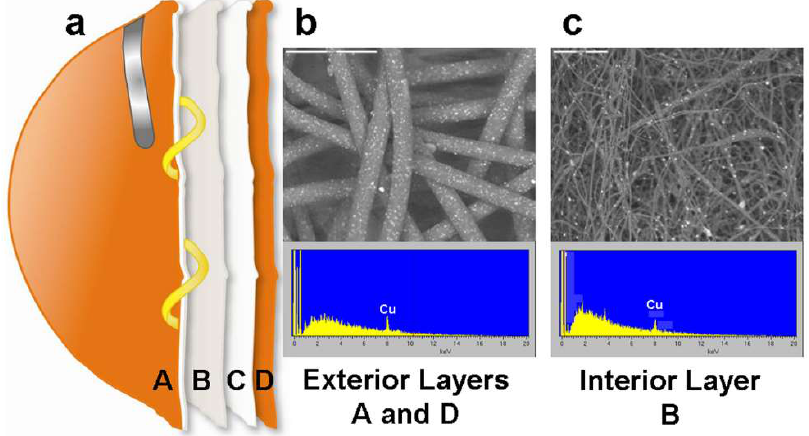
Figure 11. ( a ) Four distinct layers of the respirator, ( b ) SEM and XRD of layer A and D and ( c )